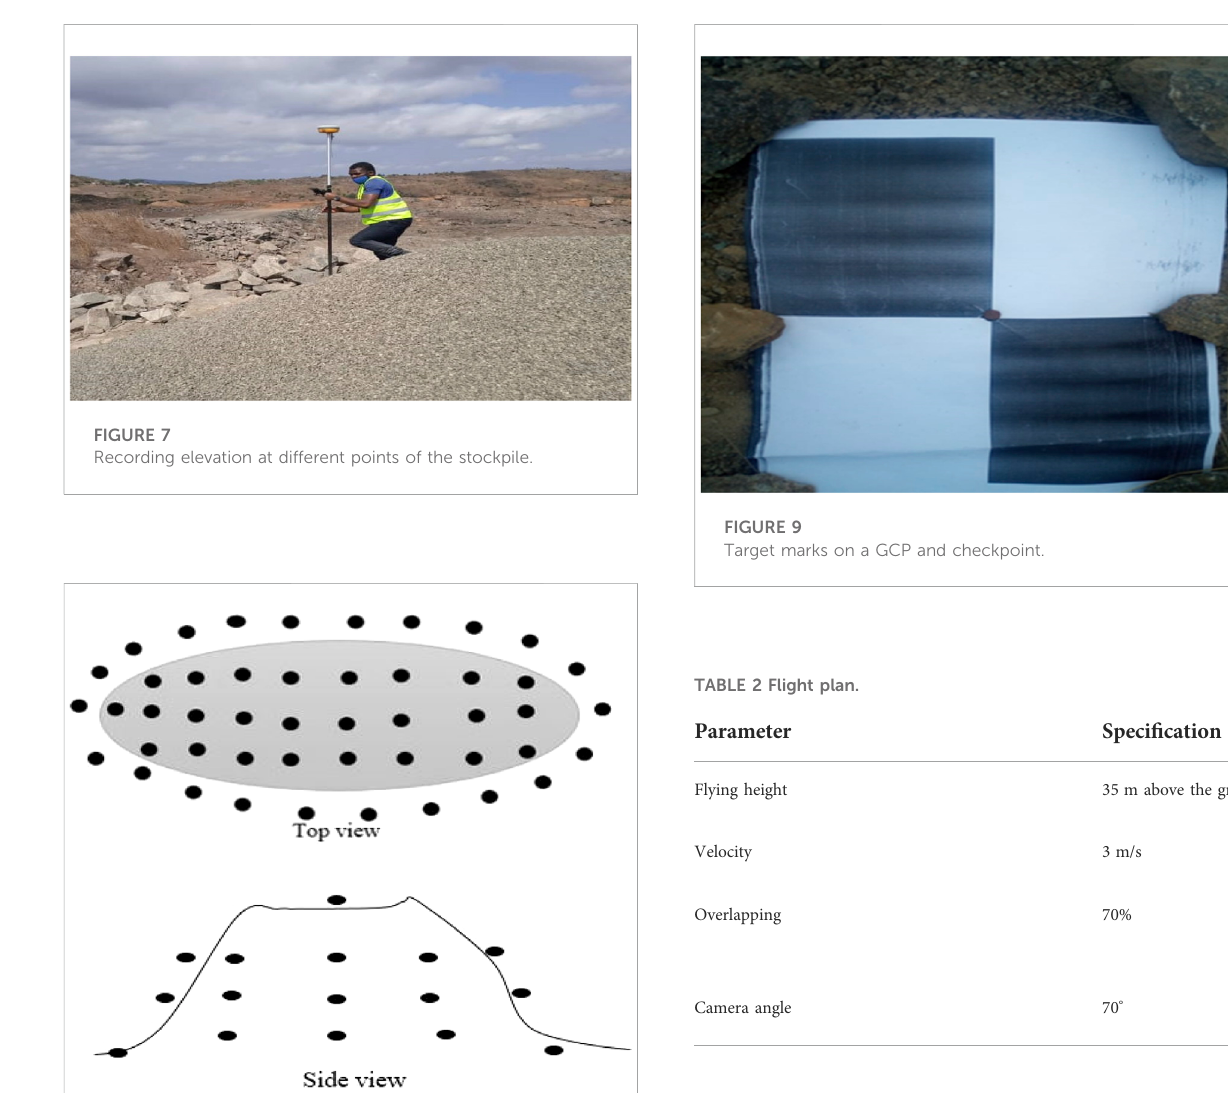
FIGURE 8 Elevation points distribution on a stockpile.